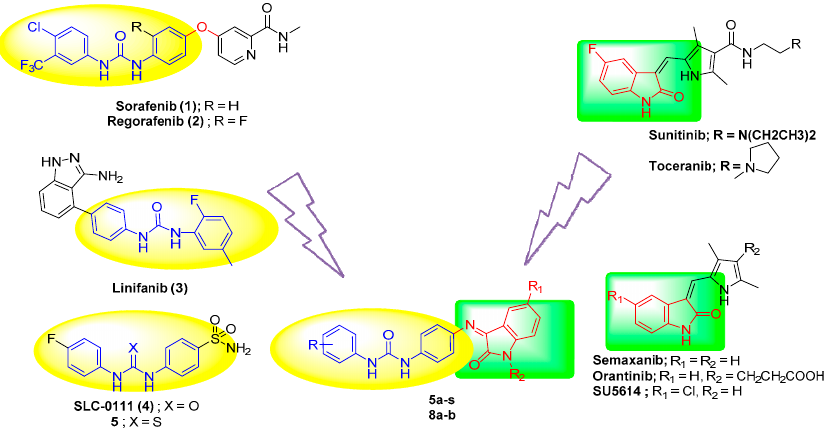
Figure 1. Biphenylurea derivatives and indolinone derivatives as anticancer agents and the proposed structures 5a – s and 8a , b .